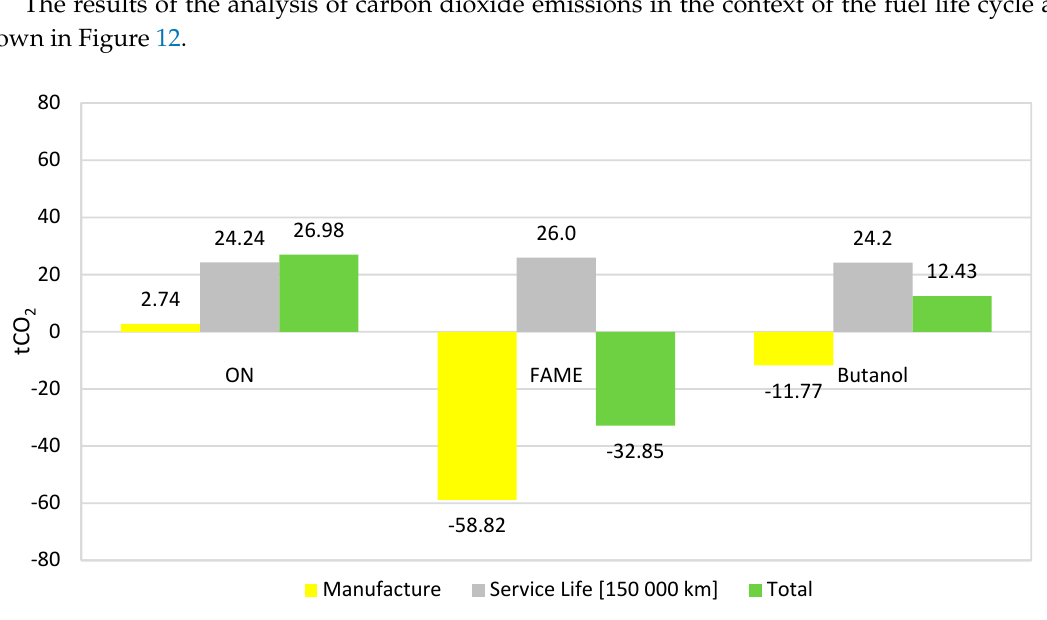
Figure 12. Comparison of carbon dioxide emissions from fuels in the context of the fuel life cycle.